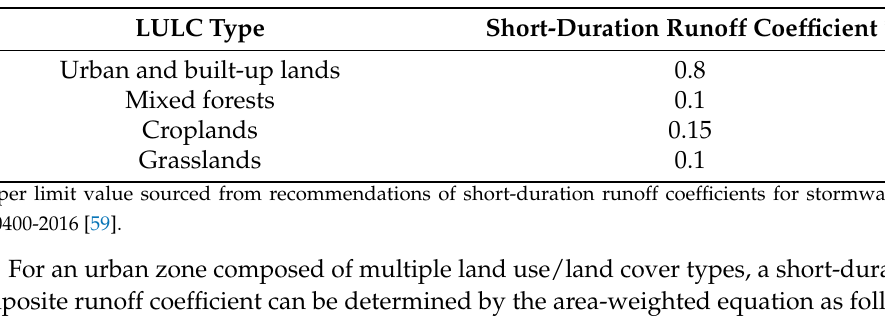
Table 2. Short-duration runoff coefficient (upper limit) for land use/land